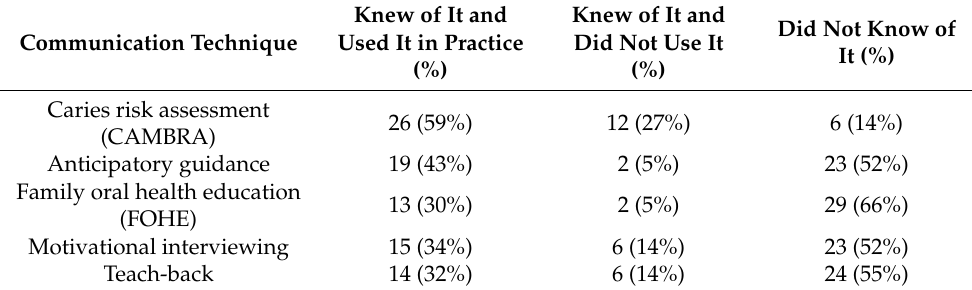
Table 2. Provider knowledge and use of five types of oral health assessment and educational strategies in practice * ( n =